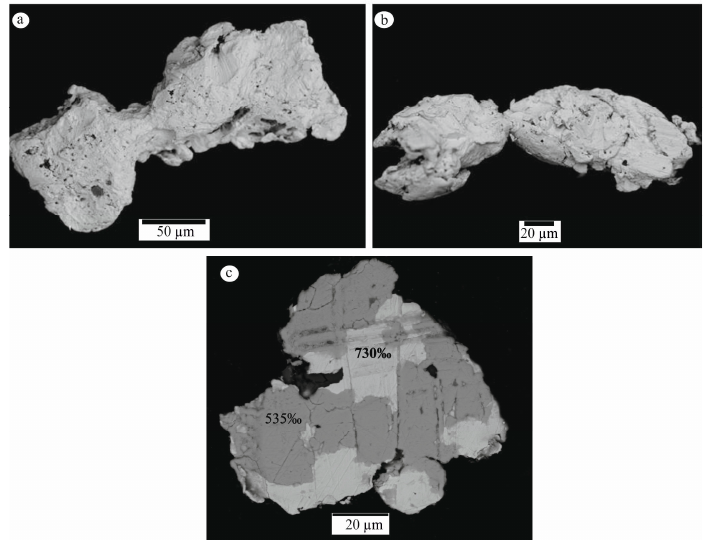
Figure 7. Morphology and internal structure of gold of the Nebaibyt river placer: ( а ) lamellar gold (general view); ( b ) very high-grade (990‰) intergranular veinlets in high-grade gold (950‰); ( c ) granulation structures of high-grade gold, etched with a reagent based on aqua regia; ( b , c ) shot in BSE mode.